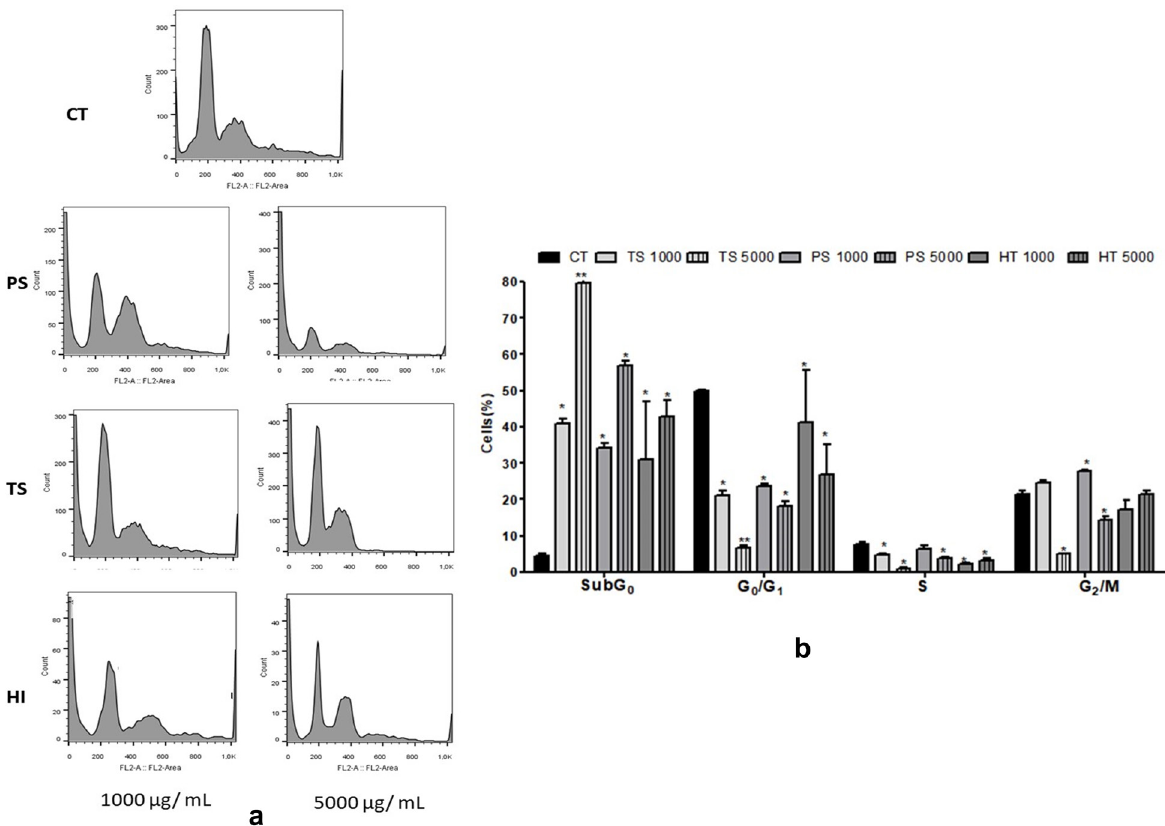
Figure 4. Effect of 24hrs-incubation of MCF-7 cells with 1000 and 5000 μg/ mL of Pedro Sato (PS), Tsumori (TS) and Hitígio (HI) guava cultivars extracts on cell cycle progression. Cell cycle phases are illustrated in (a). Quantitative results are shown in graph (b). Results are expressed as mean ± standard deviation of two experiments. Results of untreated (CT) and treated cells were compared by One- way ANOVA followed by Tukey test. Significant differences are indicated as * p<0.05 and ** p